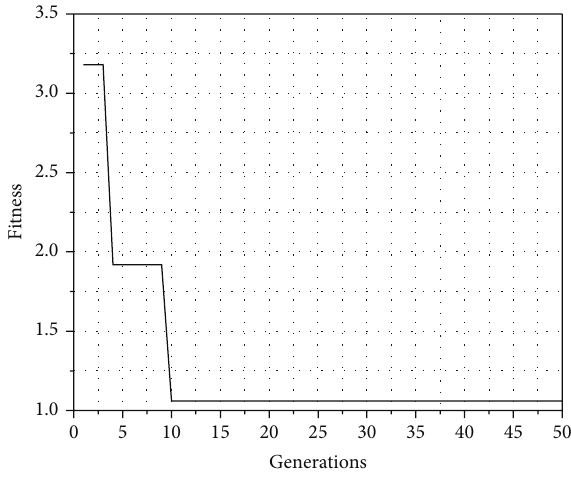
Figure 3: Fitness optimization. Figure 4: Behavior of the average power.